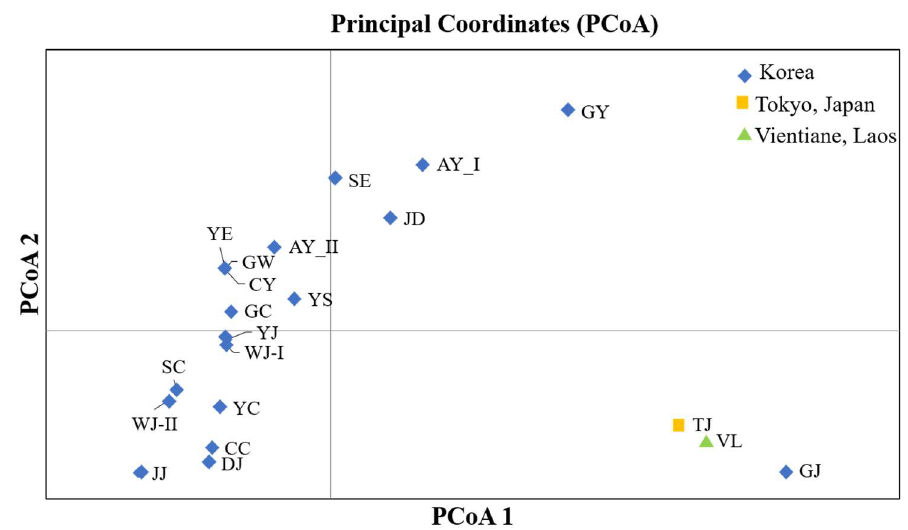
Figure 2. Principal Coordinates Analysis (PCoA) generated using mitochondrial DNA (mtDNA) of Aedes albopictus. The analyzed mtDNA sample sequences were collected from Korea (blue), Tokyo, Japan (yellow), and Vientiene, Laos (green). Table 2. Analysis of Molecular Variance of Aedes albopictus with concatenated sequences of mitochon- drial